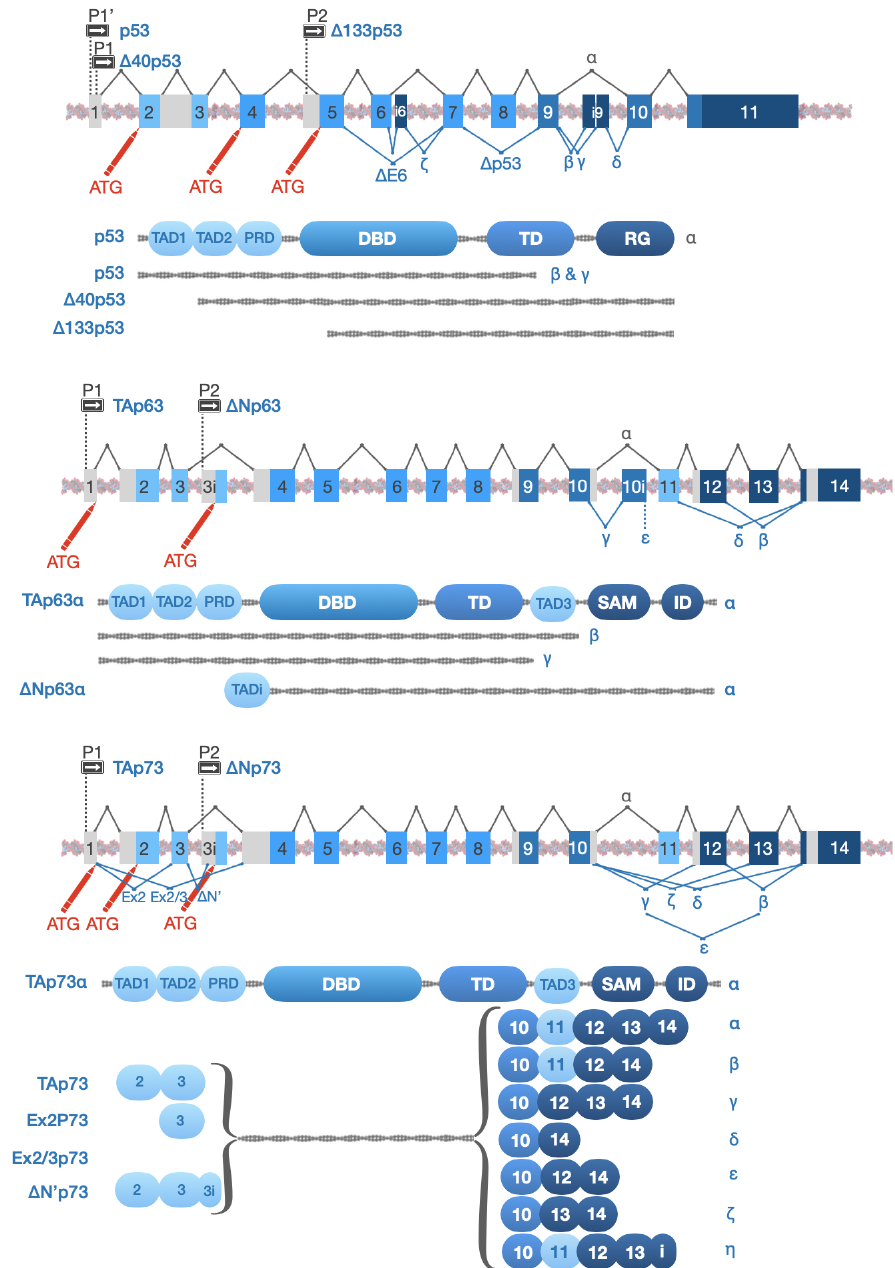
Figure 2. The isoforms of the p53 family. The p53 family has 3 genes: TP53 , TP63 , and TP73 , that express multiple isoforms via alternative promoters (P1, P 1′ , and P2), generating full-length proteins with N-terminus transactivation domains (e.g., TA) or without (e.g., ∆N) and alternative splicing generating variations in the C-terminus (e.g., α , β , and γ ). The encoded proteins contain transactivation domains (TAD1, 2, and 3); a proline-rich region (PRD); a DNA-binding domain (DBD), tetramerization domain (TD), sterile α domain (SAM), and an inhibitor domain (ID).